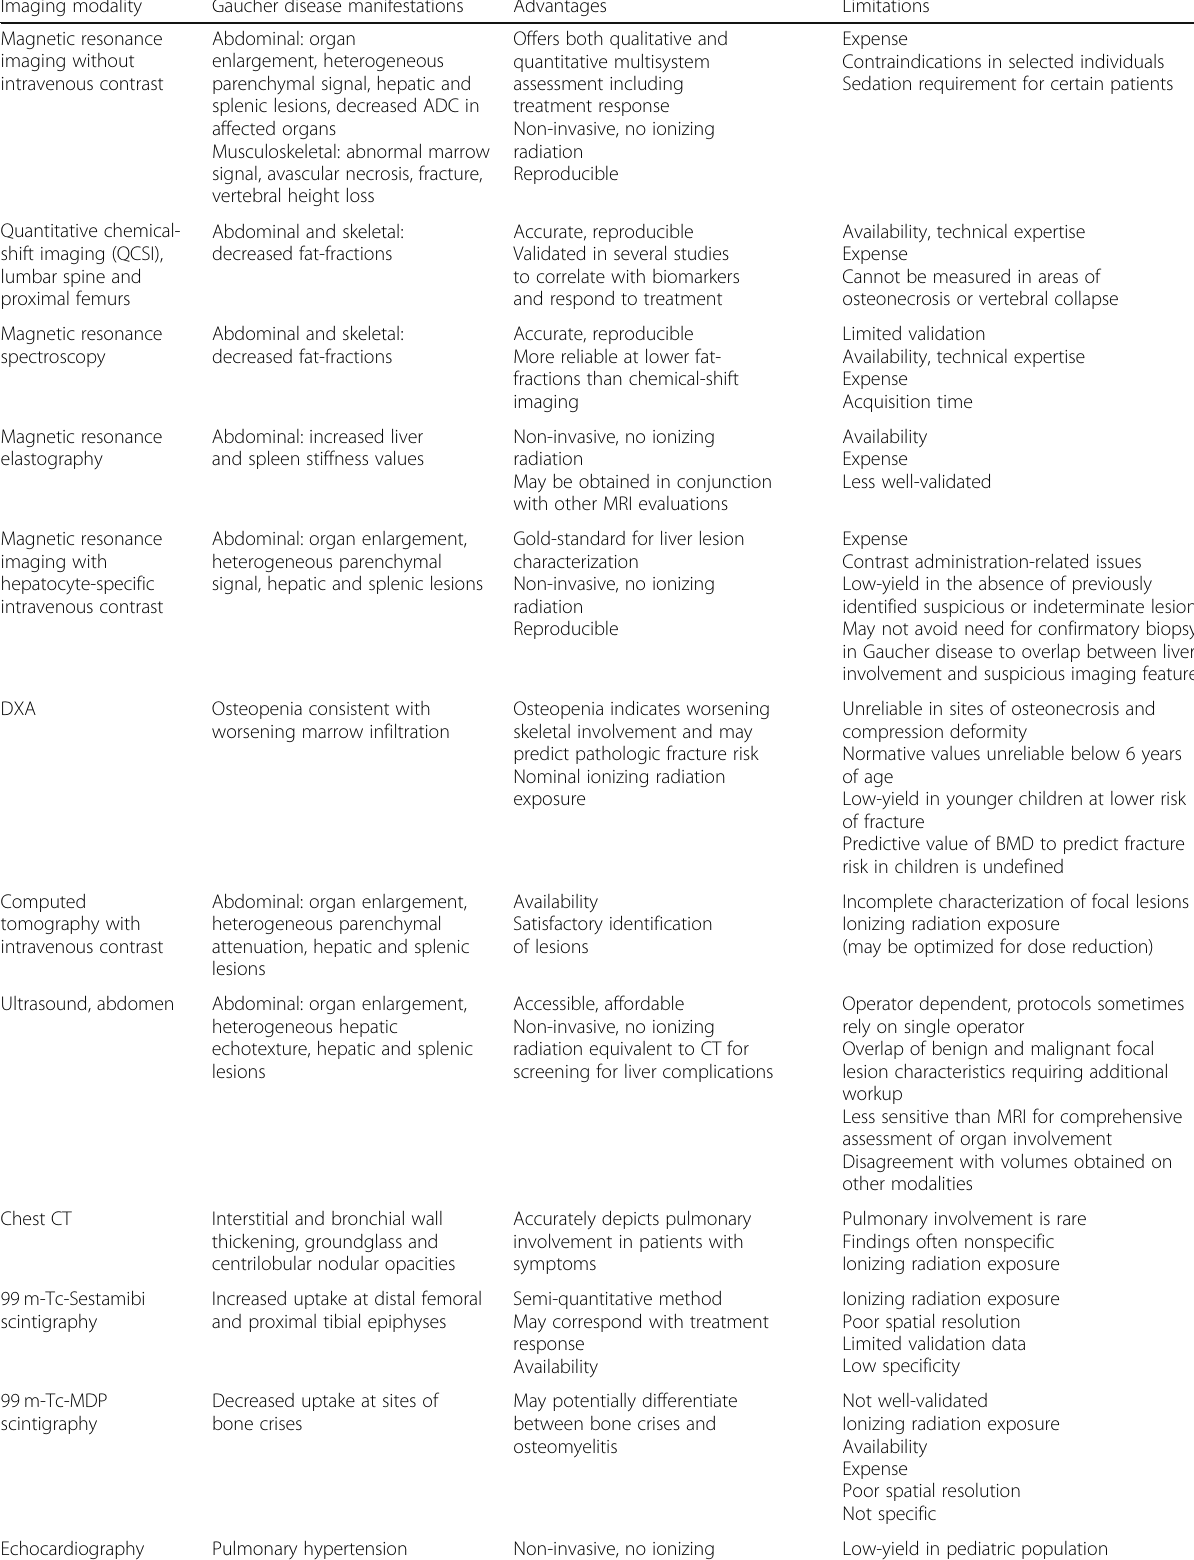
Table 4 Imaging modalities relevant to Gaucher disease Imaging